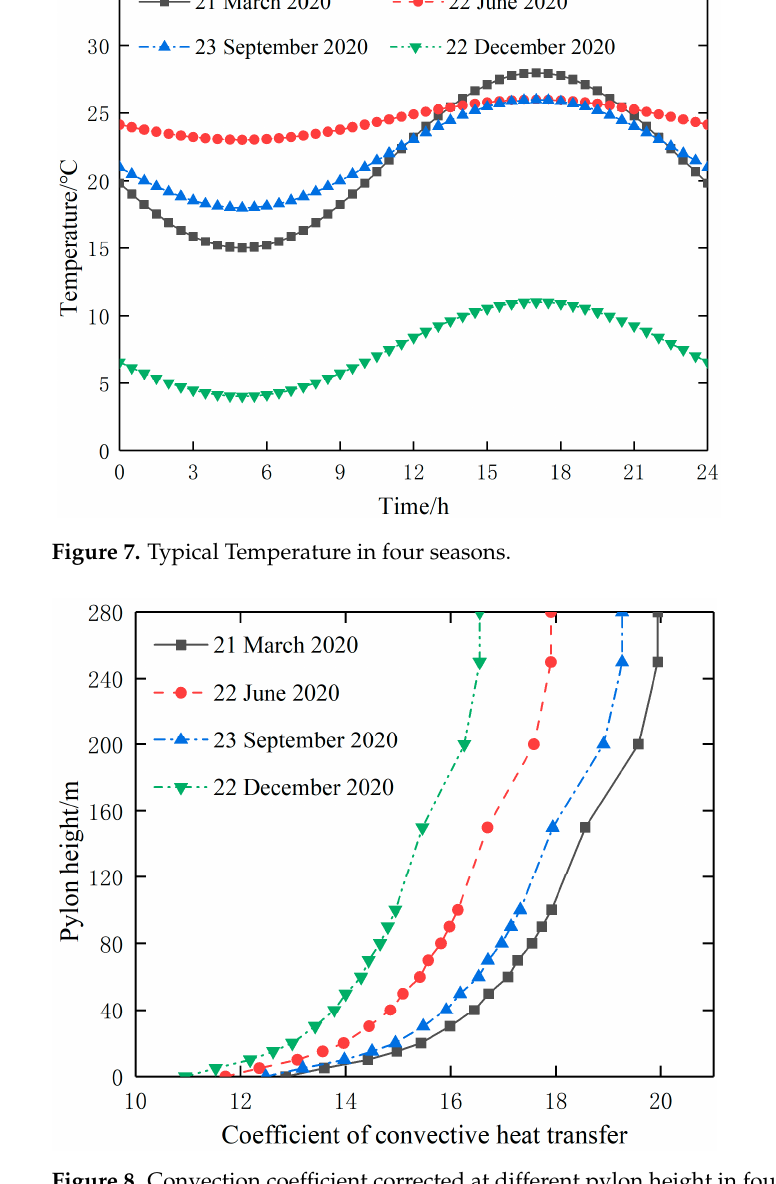
Figure 8. Convection coe ffi cient corrected at di ff erent pylon height in four seasons.